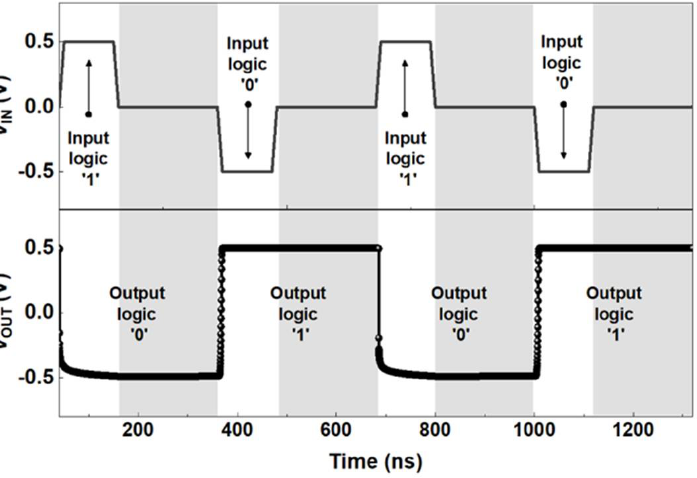
Figure 5. Timing diagrams of input and output voltages ( V IN and V OUT ) with supply voltages V DD = 0.5 V and V SS = −1.3 V. V IN is applied with a logic pulse width of 100 ns.